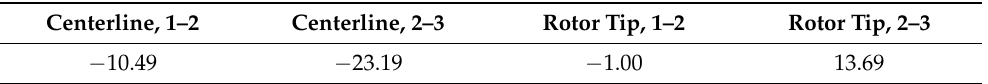
Table 3. The percent difference in in-plane divergence between control and treatment for each PIV